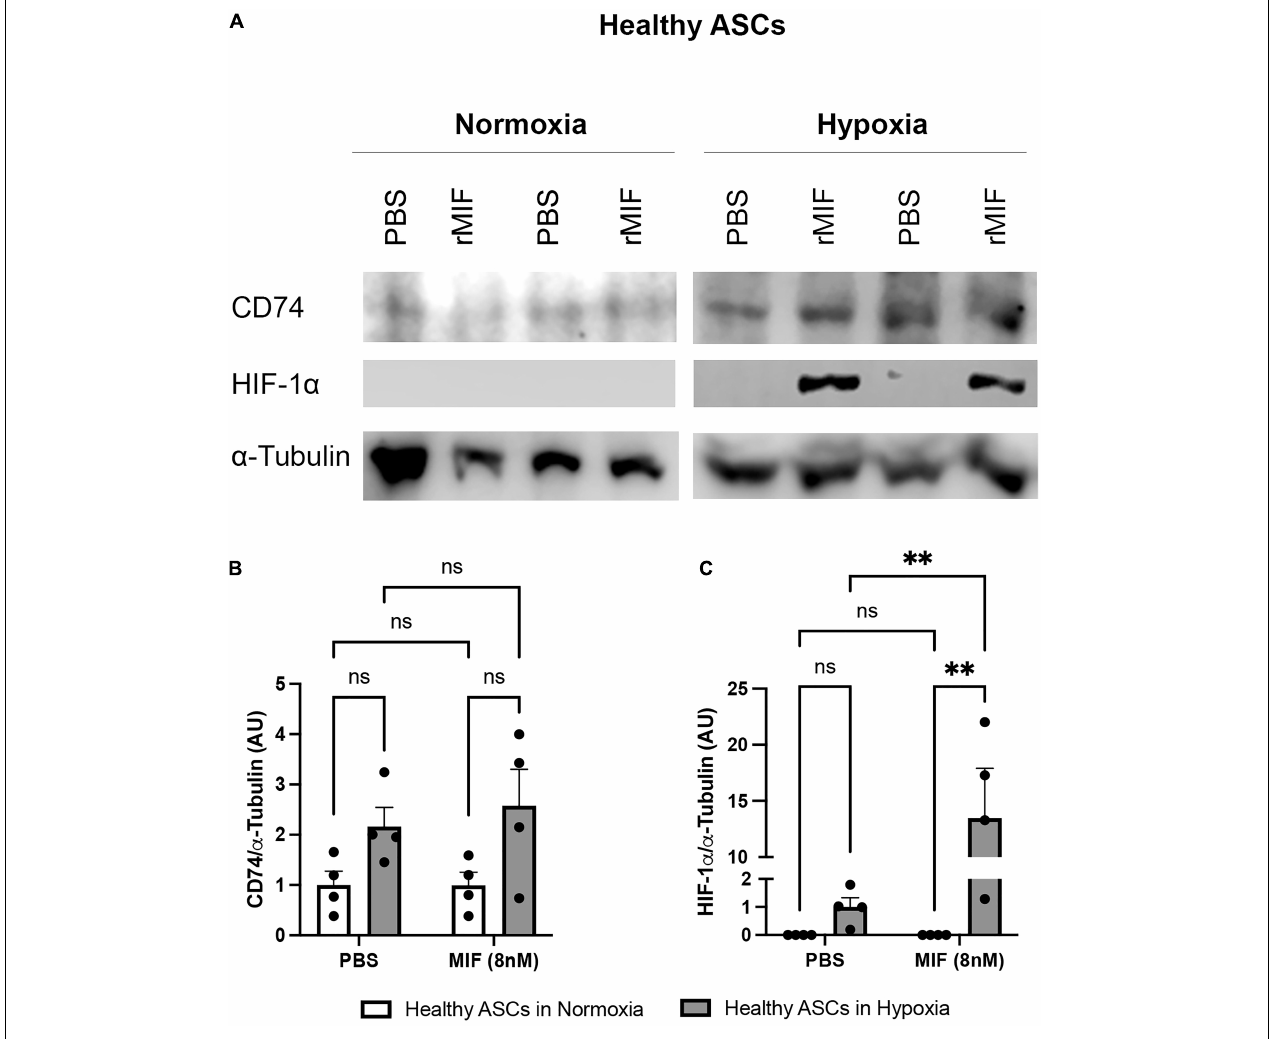
FIGURE 8 | HIF-1 α and CD74 expression after MIF stimulation in normoxic and hypoxic ASCs. ASCs from healthy donor sites (Group A) were stimulated with 100 ng/ml of recombinant MIF and cultured in growth medium at normoxic oxygen levels of 21% O 2 or hypoxic oxygen levels of < 1% O 2 . Control cells (0 ng/ml) received PBS as vehicle. Cells were lysed 24 h after induction of hypoxia and Western blot analysis was performed and evaluated using Image J software. Tubulin was detected for total protein standardization. (A) Representative blots of HIF-1 α and CD74 expression in normoxic and hypoxic ASCs are depicted. Analyses were performed on four biological replicates ( n = 4). Band intensities were quantified and graphically displayed as (B) relative CD74/tubulin and (C) relative HIF-1 α /tubulin and normalized to the respective control group (PBS + normoxia). Data are mean values ± SEM (two-way ANOVA, Holm-Šídák’s multiple comparisons test, ∗∗ p <